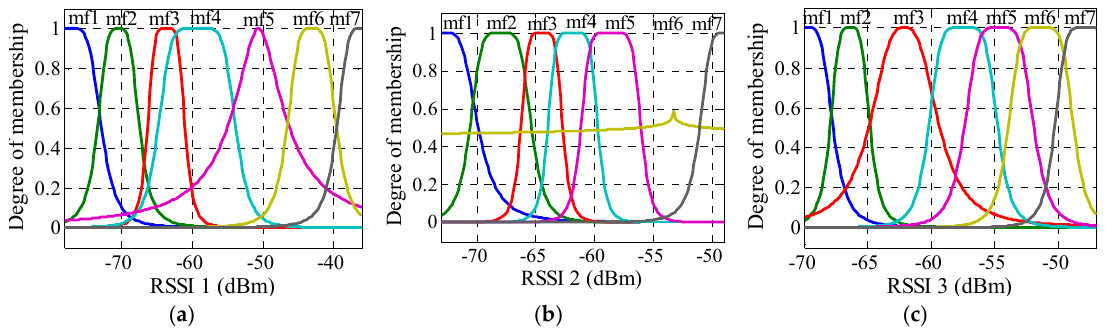
Figure 11. ANFIS seven gbellmfs input of indoor velodrome ( a ) RSSI 1; ( b ) RSSI 2; and ( c ) RSSI 3.